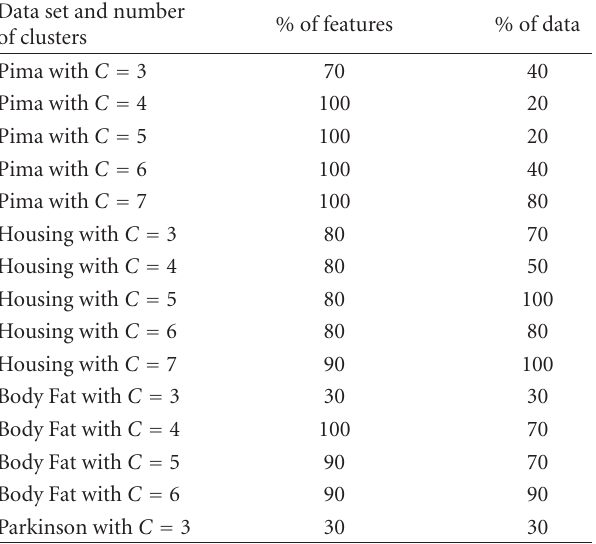
Table 7: The optimal % of features and data for di ff erent